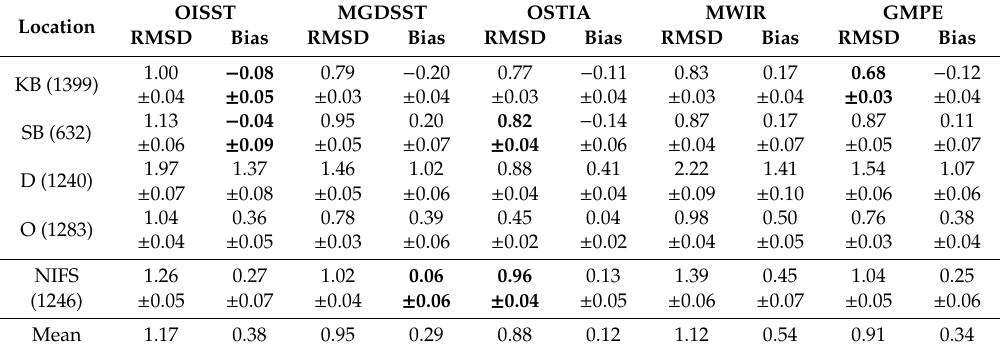
Table 3. Root mean square di ff erence (RMSD) and bias of SST data obtained from in situ (the ocean buoys and conductivity-temperature-depth (CTD) measurements and remote sensing (satellite observation). The smallest RMSD and bias relative to KB, SB, and NIFS observations are given in bold face. The number of matchup data is given in parentheses.